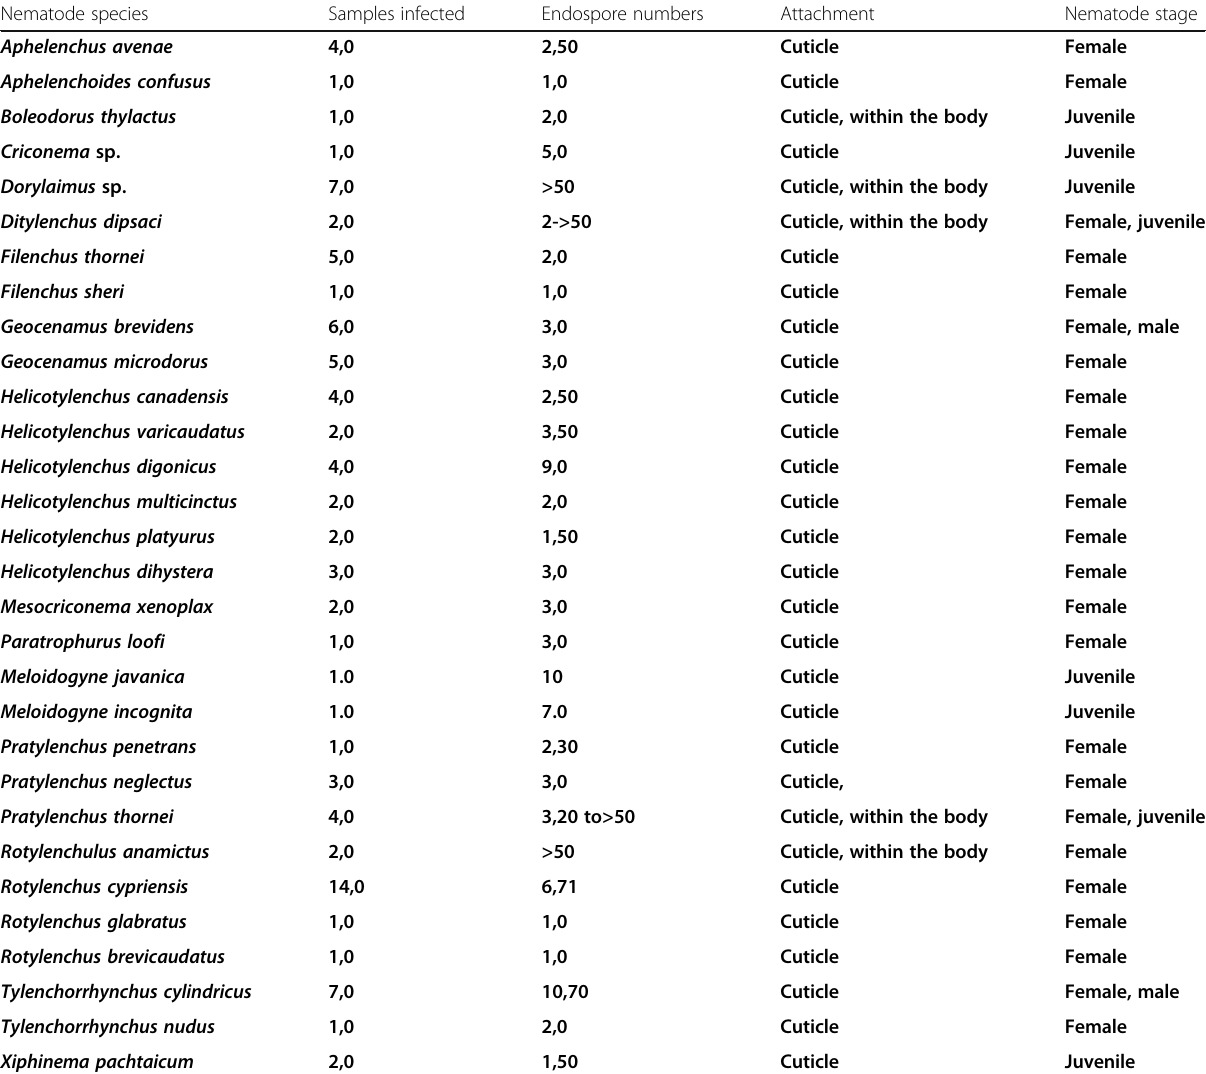
Table 2 The list of plant parasitic nematodes, the number of soil samples infected, attachement rate, nematode stage in Northwestern Marmara Region Nematode